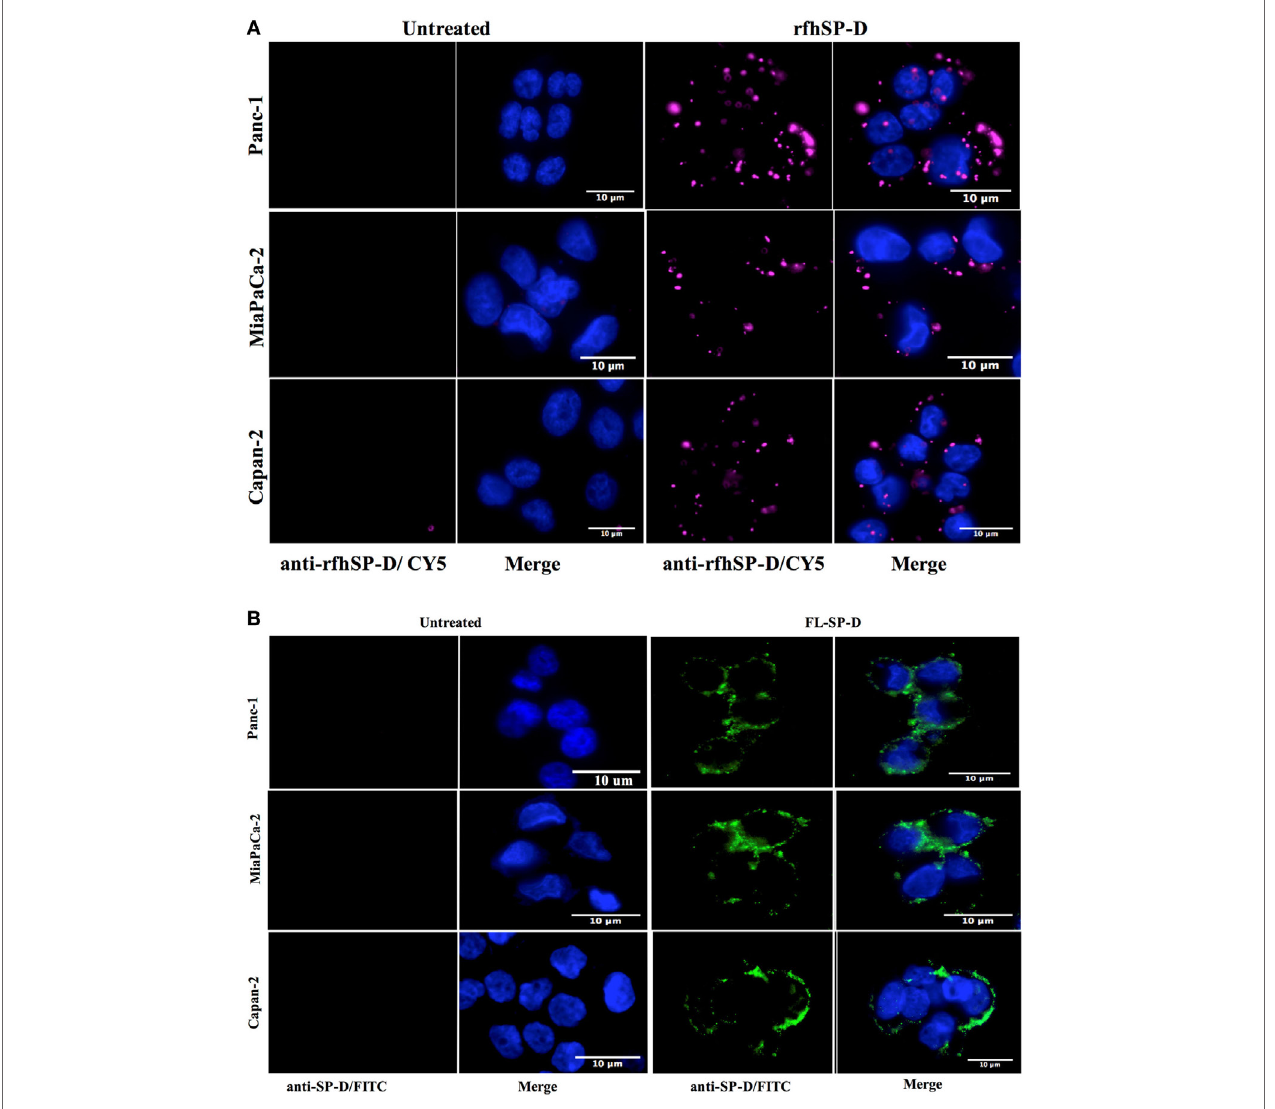
FigUre 1 | (a) Fluorescence microscopy showing binding of rfhSP-D and (b) FL-SP-D (10 µg/ml; 1 h incubation) to Panc-1, MiaPaCa-2, and Capan-2 cells. The nucleus of the cells was stained with Hoechst. Cells were probed with mouse anti-human SP-D/CY5 (rfhSP-D) and rabbit anti-human/FITC (FL-SP-D); the bound proteins are visible on the cell membrane in the treated cells. No CY5 or FITC fluorescence was detected in the untreated control